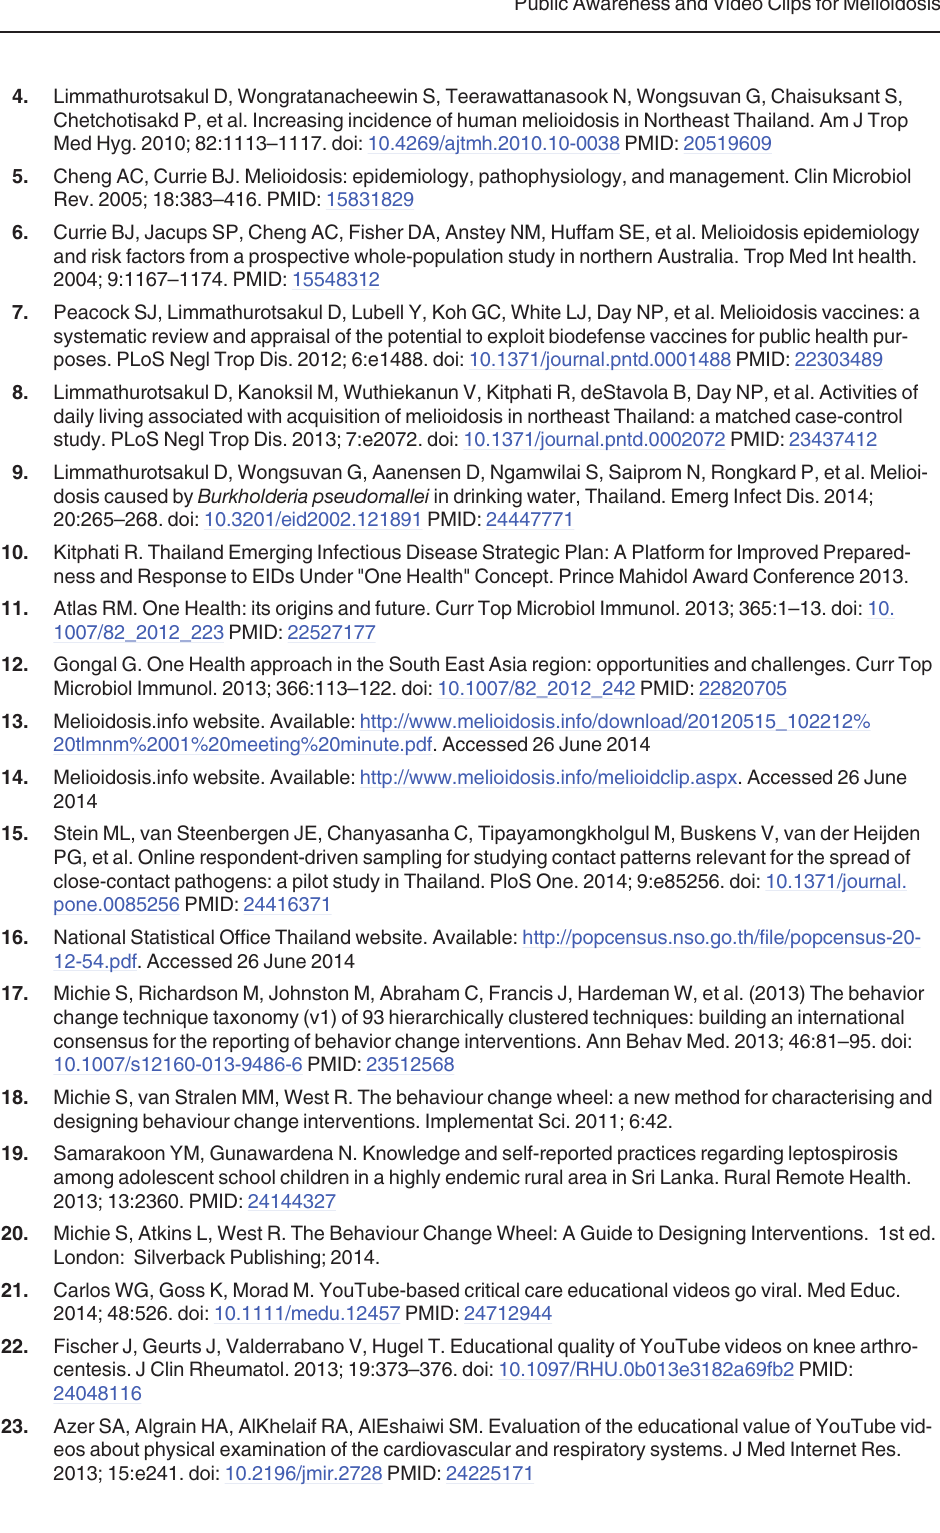
PLOS ONE | DOI:10.1371/journal.pone.0121311 March 24,